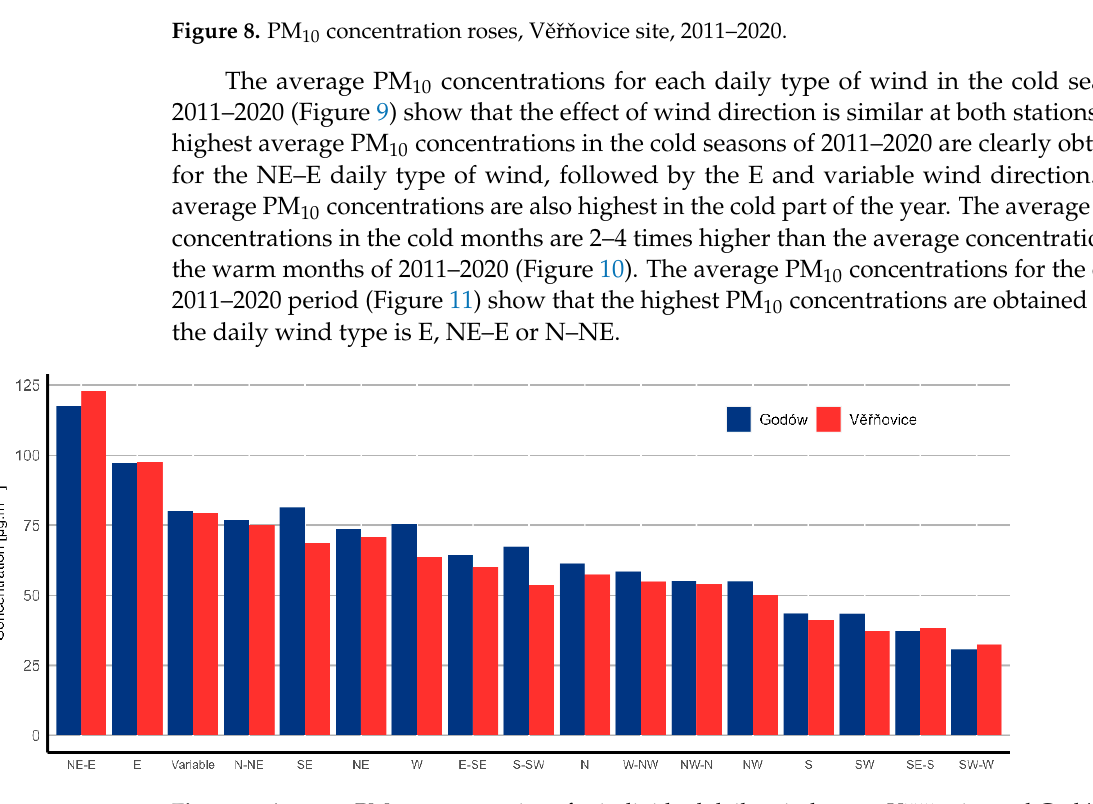
Figure 8. PM 10 concentration roses, Vˇeˇrˇnovice site, 2011–2020.